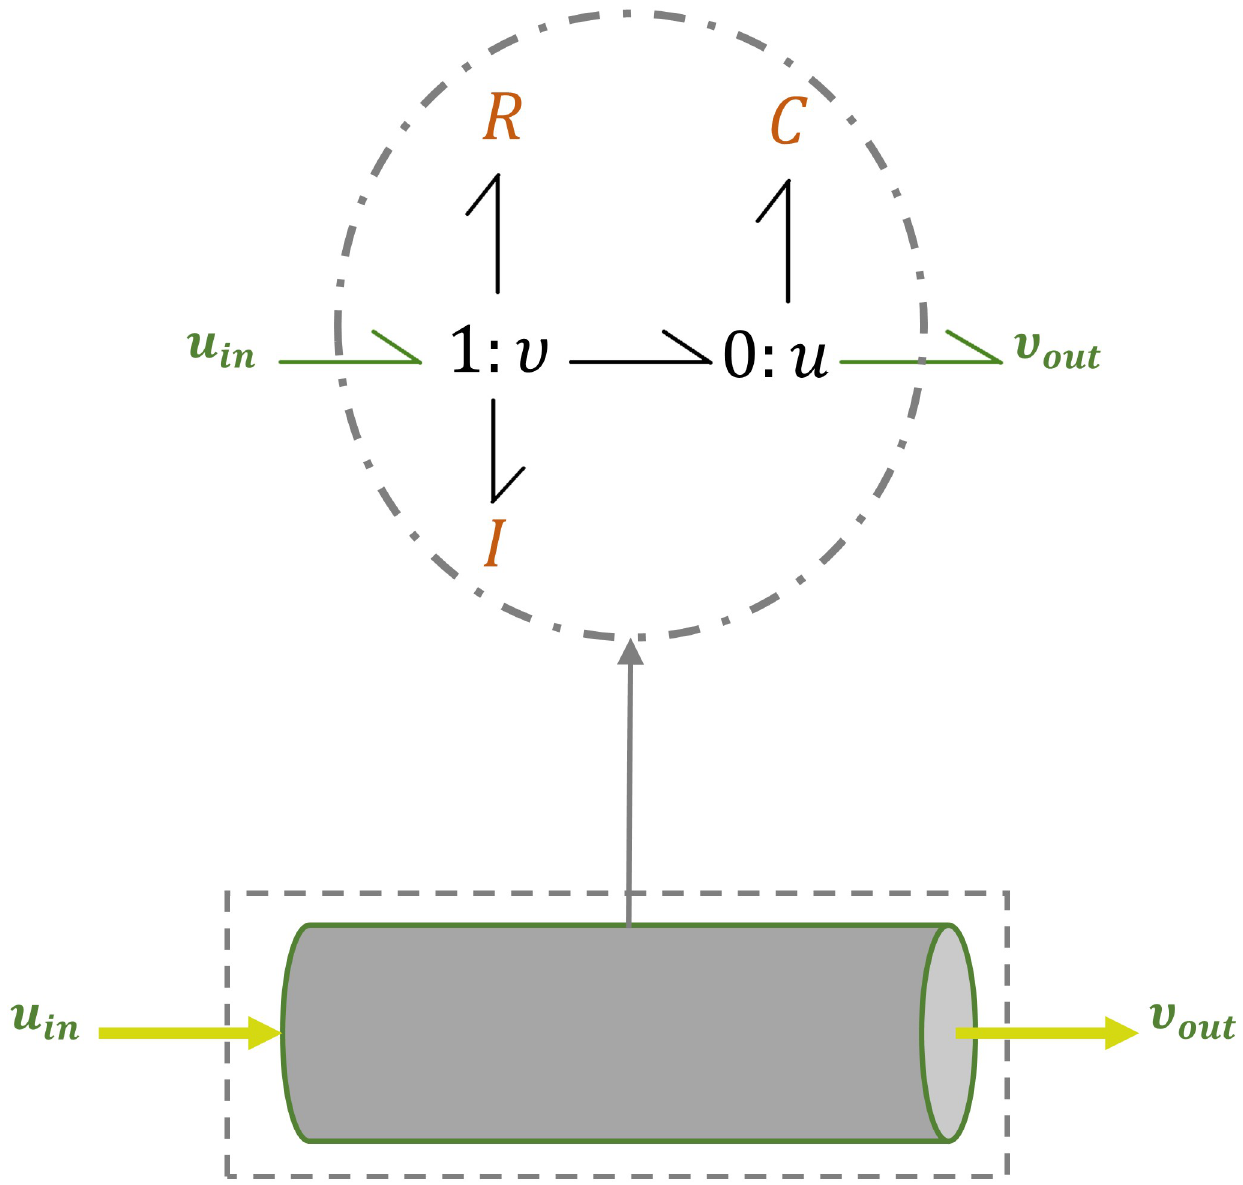
Fig 2. Bond graph representation of a non-branching vessel. C , R and I components show the mechanical properties of a vessel segment.